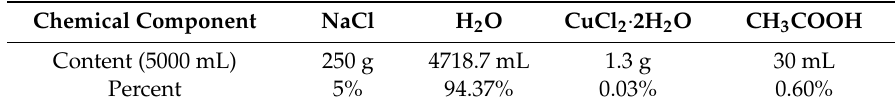
Figure 2. ( a,b ) Spray device.